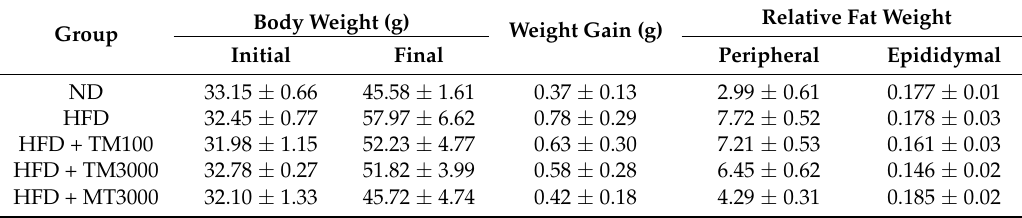
Table 1. Effect of oral administration of Tenebrio molitor larvae (TML) on body weight gain and fat weight in mice fed a high-fat diet.